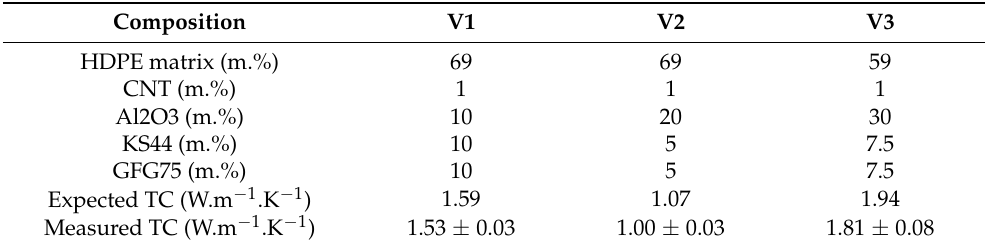
Table 3. Extra compositions as validation of the response surface model (RSM) and the expected thermal conductivity of the extra compositions, in combination with the measured values.